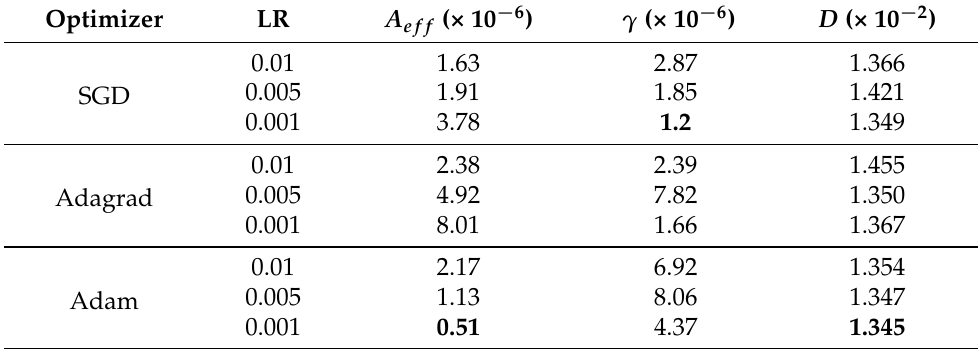
Table 8. MSE averages for models trained using different training configurations (optimizer and LR) predict different optical properties, the bold denotes the optimal in this